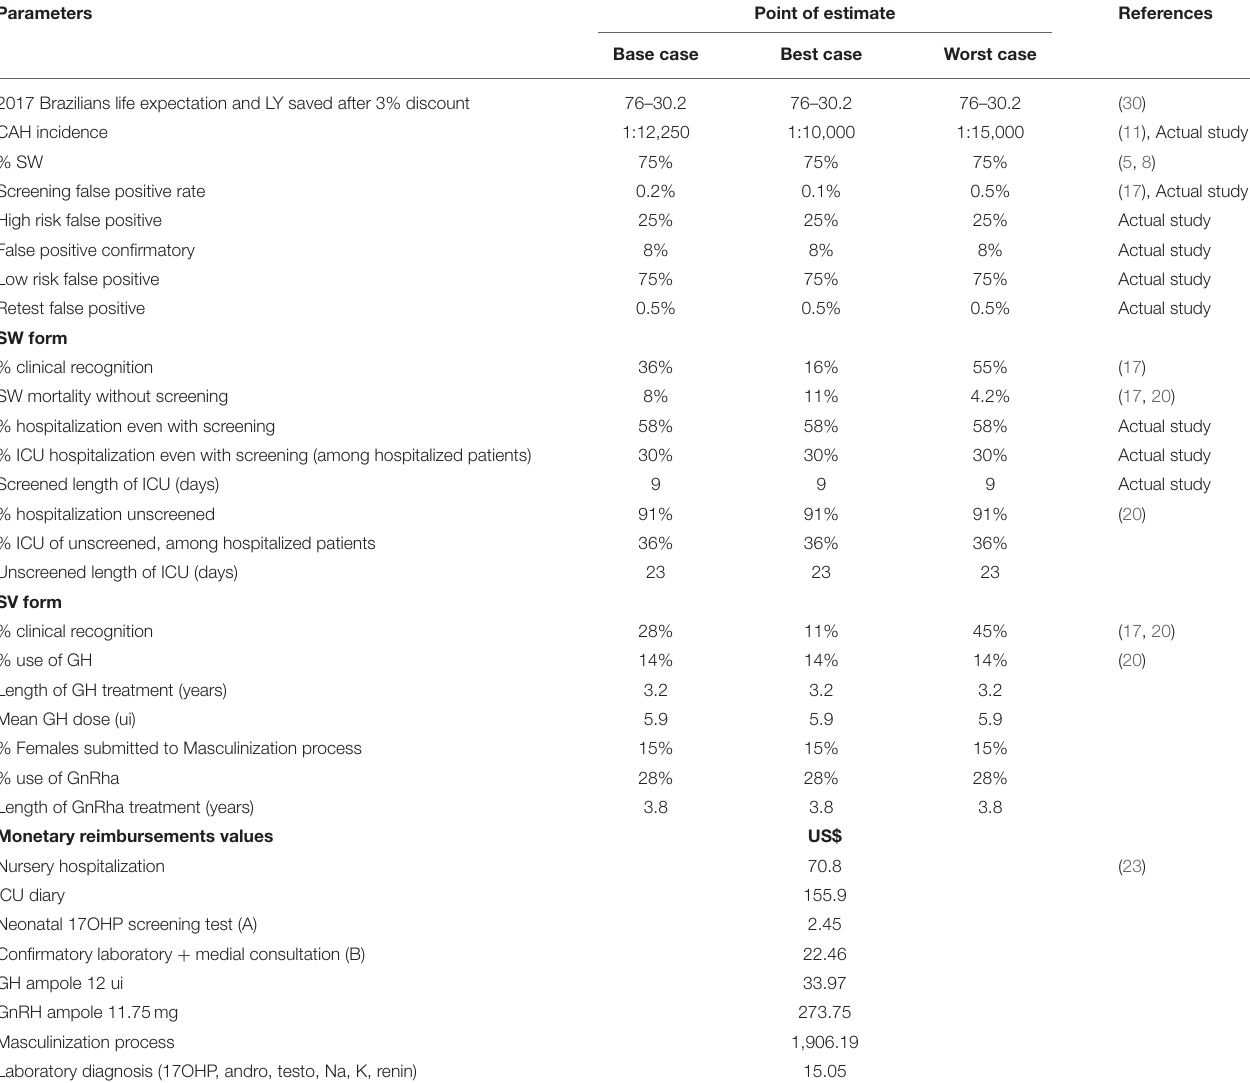
TABLE 2 | Parameters and its point estimate assumption in modeling the base, best- and worst-case scenarios in decision analysis for CAH-NBS.